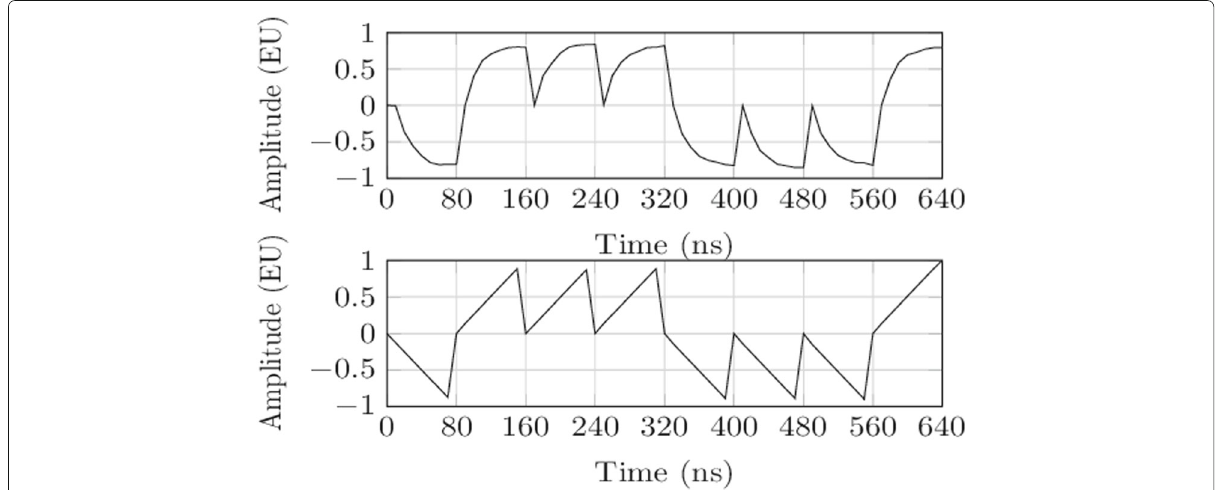
Fig. 3 Loop filter’s output: low-pass (top) and integrator (down). The filter’s output is a continuous function in the current time interval with the polarity aligned to the antipodal source symbol. The threshold for ML detection is zero